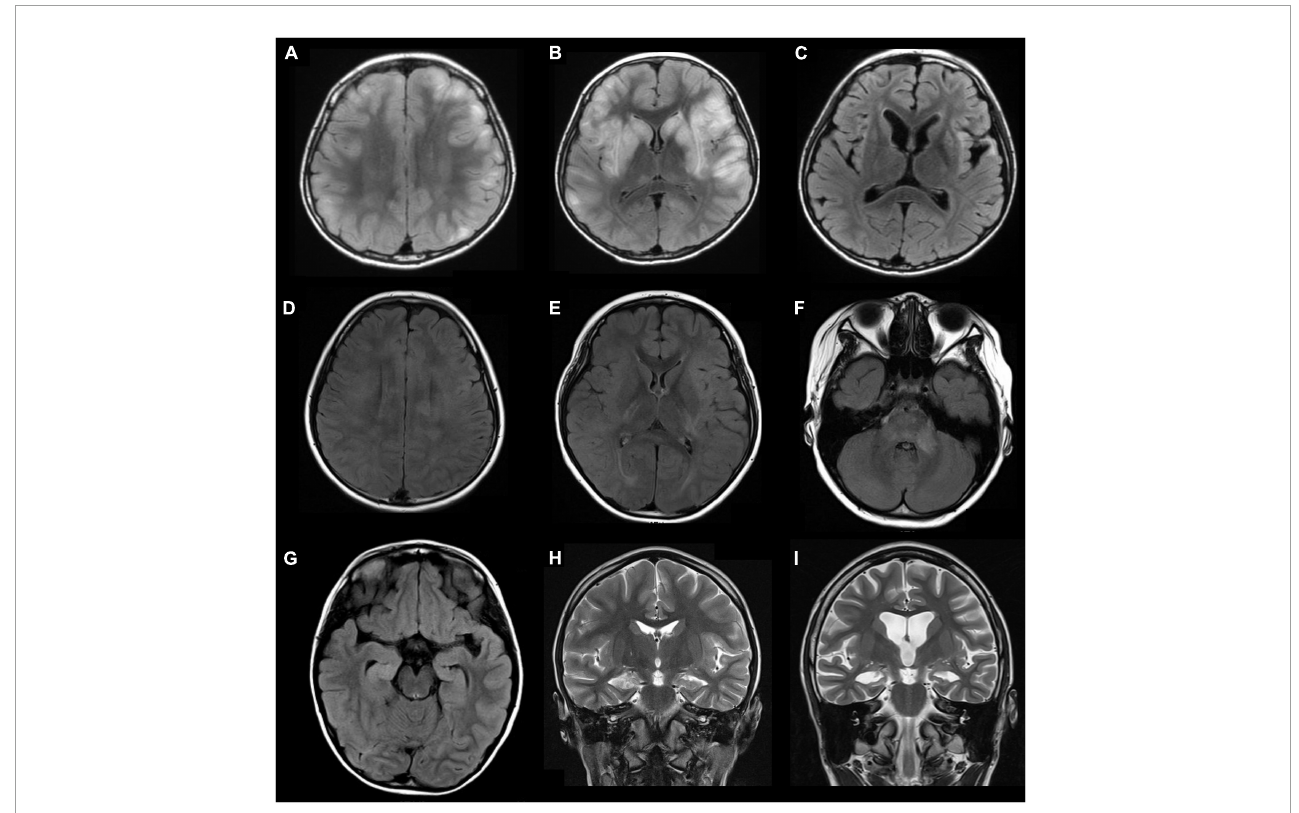
FIGURE1 Examples of abnormal brain magnetic resonance imaging (MRI) findings in three patients with pediatric encephalitis/encephalopathy with anti-GAD antibody. Patient 1: A 10-year-old boy with clinical diagnosis of encephalitis with preceding influenza B infection 6 days ago. (A,B) Axial fluid-attenuated inversion recovery (FLAIR) sequences show multiple increased signals in the basal ganglia and cortical/subcortical regions of bilateral cerebral hemispheres (frontal, parietal, temporal lobes). (C) MRI follow-up at 9 months show progressive atrophy with stationary hyperintensities in bilateral putamen, bilateral insular regions, and left temporal tip. Patient 2: A 9-year-old girl with clinical diagnosis of rhombencephalitis with preceding HSV-1 infection 6 days ago. (D–F) Axial FLAIR sequences demonstrate multiple increased signals in the corpus callosum, bilateral insular regions, bilateral posterior capsules, and multiple cortical areas and white matter of bilateral hemispheres (all lobes), the brainstem, and left middle cerebellar peduncles. Patient 3: A 6-year-old girl with clinical diagnosis of febrile infection-related epilepsy syndrome (FIRES) without detected pathogen. (G) An axial FLAIR sequence and (H) a coronal T2 sequence show increased signals in right hippocampus and mesial temporal lobe. (I) Progressive cortical atrophy and right hippocampal atrophy were noted at the 30-month follow-up. GAD, glutamic acid